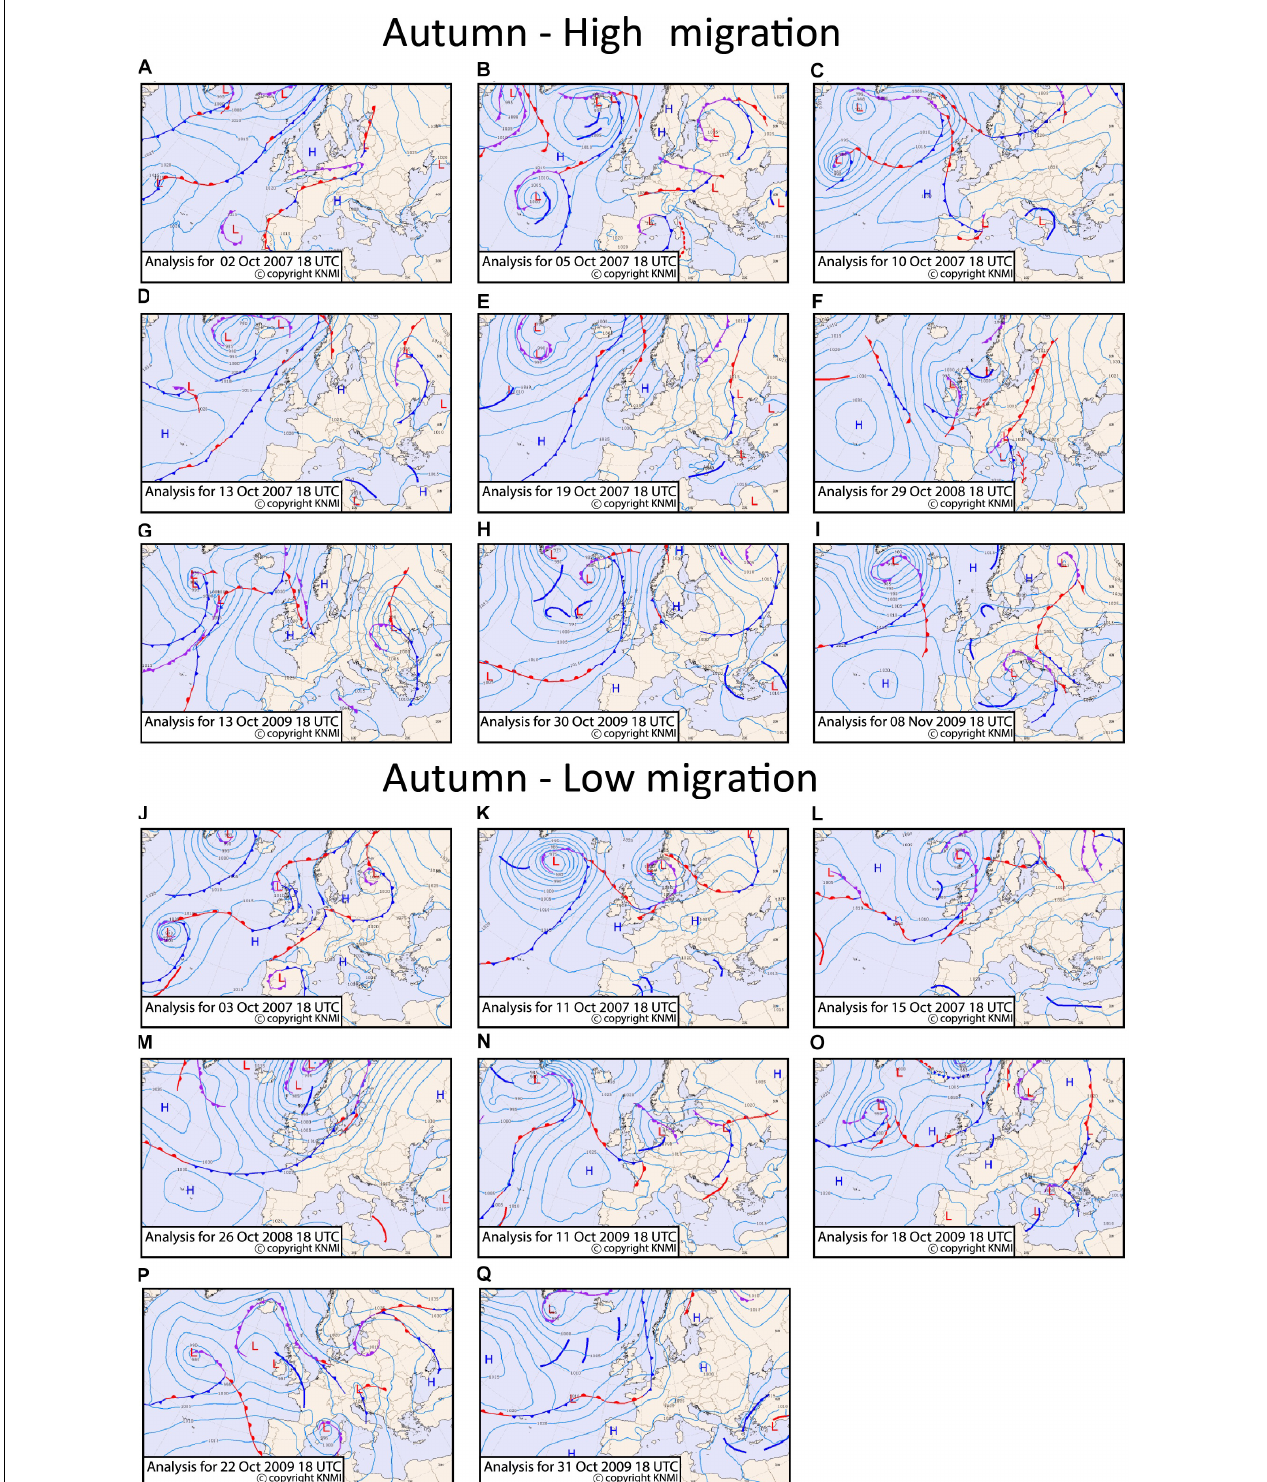
FIGURE 9 | Surface pressure and frontal systems for the high migration nights (A–I) and the low migration nights (J–Q) for autumn at 18:00 UTC. The figures are extracted from KNMI data center. The position of the core of a low pressure system is indicated with an “L” and of a high pressure system with an “H.” The cold fronts are indicated as lines in blue color, the warm fronts in red color and the occluded fronts in purple color. The side where the symbols are drawn on the front lines indicate the direction of the front’s movement. The thick blue lines indicate troughs.